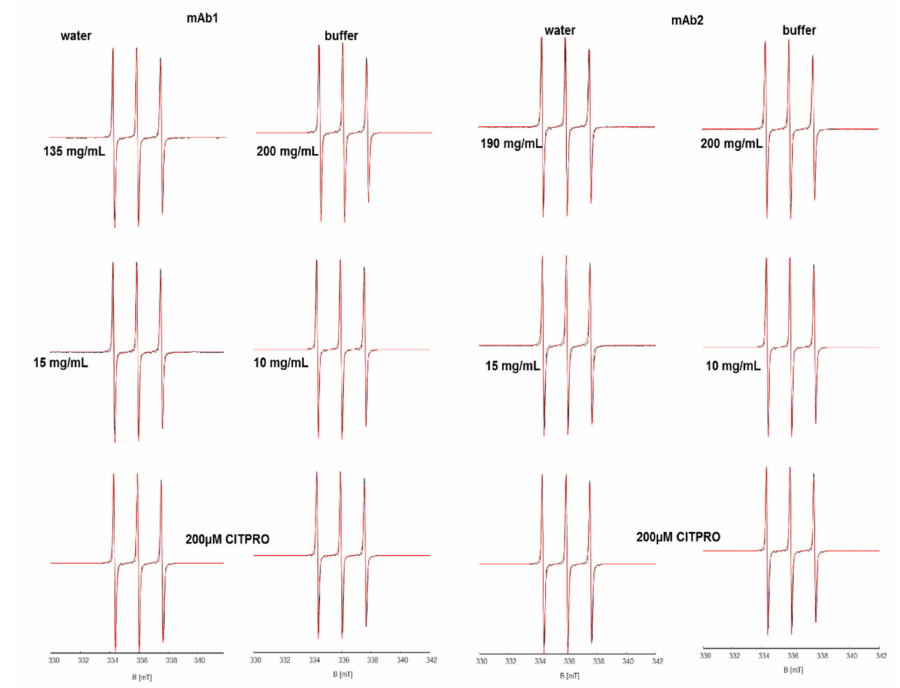
Figure 3. Experimental (black) and simulated (red) X-band CW EPR spectra of CITPRO in mAb1 and mAb2solutions of di ff erent concentrations in pure water and bu ff er are depicted. Also, the spectra of 200 µ M solution of spin probe in water and bu ff er as reference are